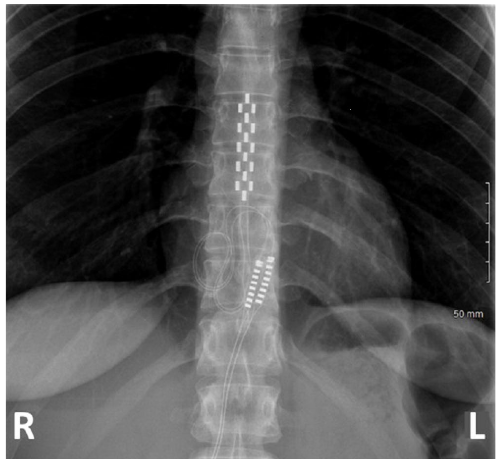
Figure 2. X-ray of a patient implanted at T8-T10 with a multicolumn lead. All patients were implanted in the prone position. The lead tip was positioned between T7 and T10, based on the level of the conus medullaris which was assessed by J. Clin. Med. 2022 , 11 , x FOR PEER REVIEW preoperative spinal magnetic resonance imaging. A radiographic assessment of lead position was conducted prior to wound closure in order to ensure anatomic midline placement, thoracic implantation level and lack of lead twisting. Finally, an impedance check ensured system integrity. In all 11 centers, other than center X, patients were implanted under conventional general anesthesia. Leads were implanted over the spinal cord segments which were supposed to receive the dorsal root fibers corresponding to the painful segment of the back. In center X, patients were implanted under awake surgery by target-controlled intravenous anesthesia (TCIVA), which enabled lead placement on the physiologic